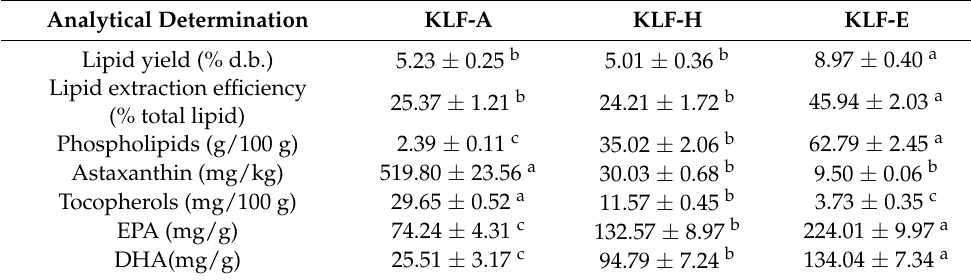
Table 2. Compositions of the three krill lipid fractions used in this study 1